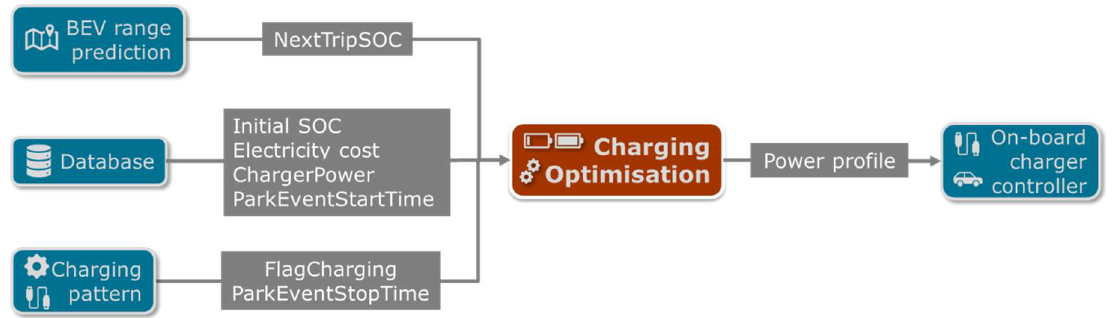
Figure 12. Charging optimisation interaction.